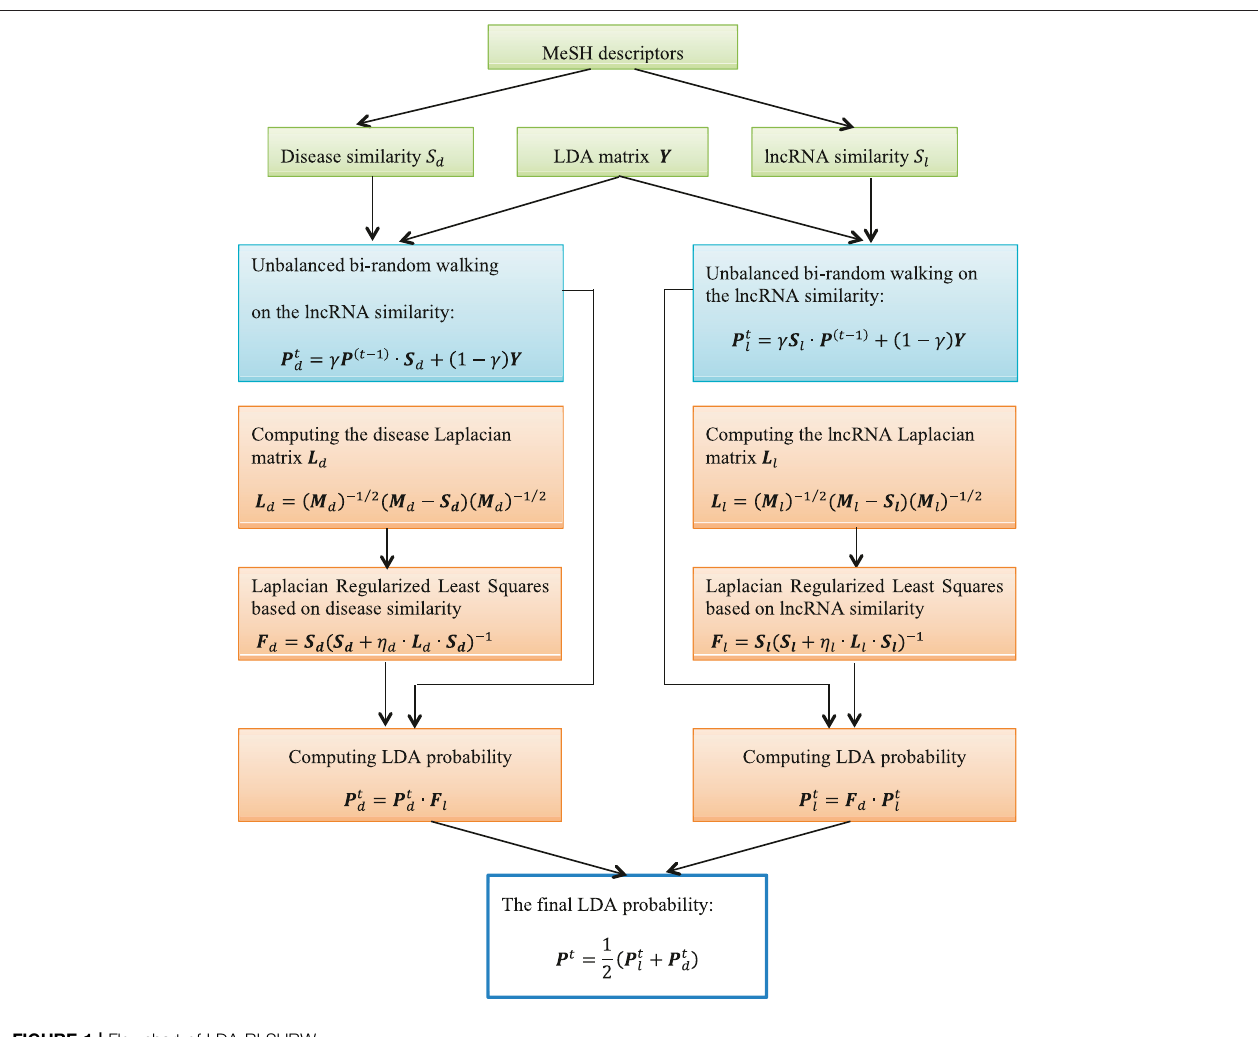
FIGURE 1 | Flowchart of